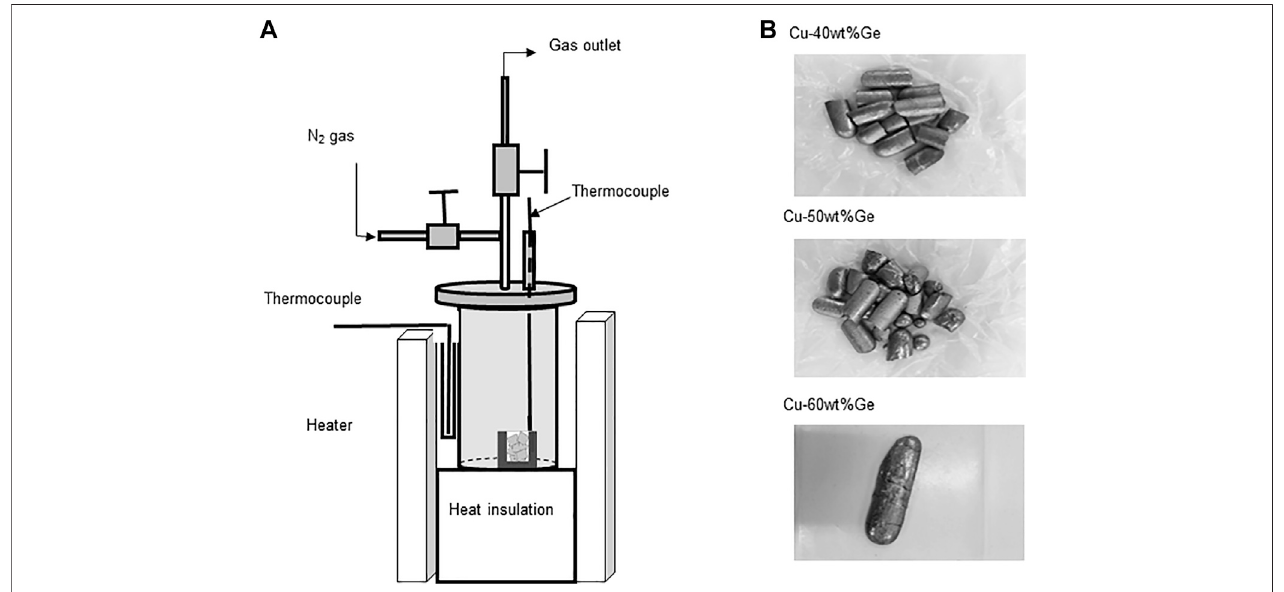
FIGURE 2 | Experimental set-up for the thermal response tests of cyclic charge/discharge modes: (A) test vessel and PCM container and (B) Cu – Ge alloy PCMs.